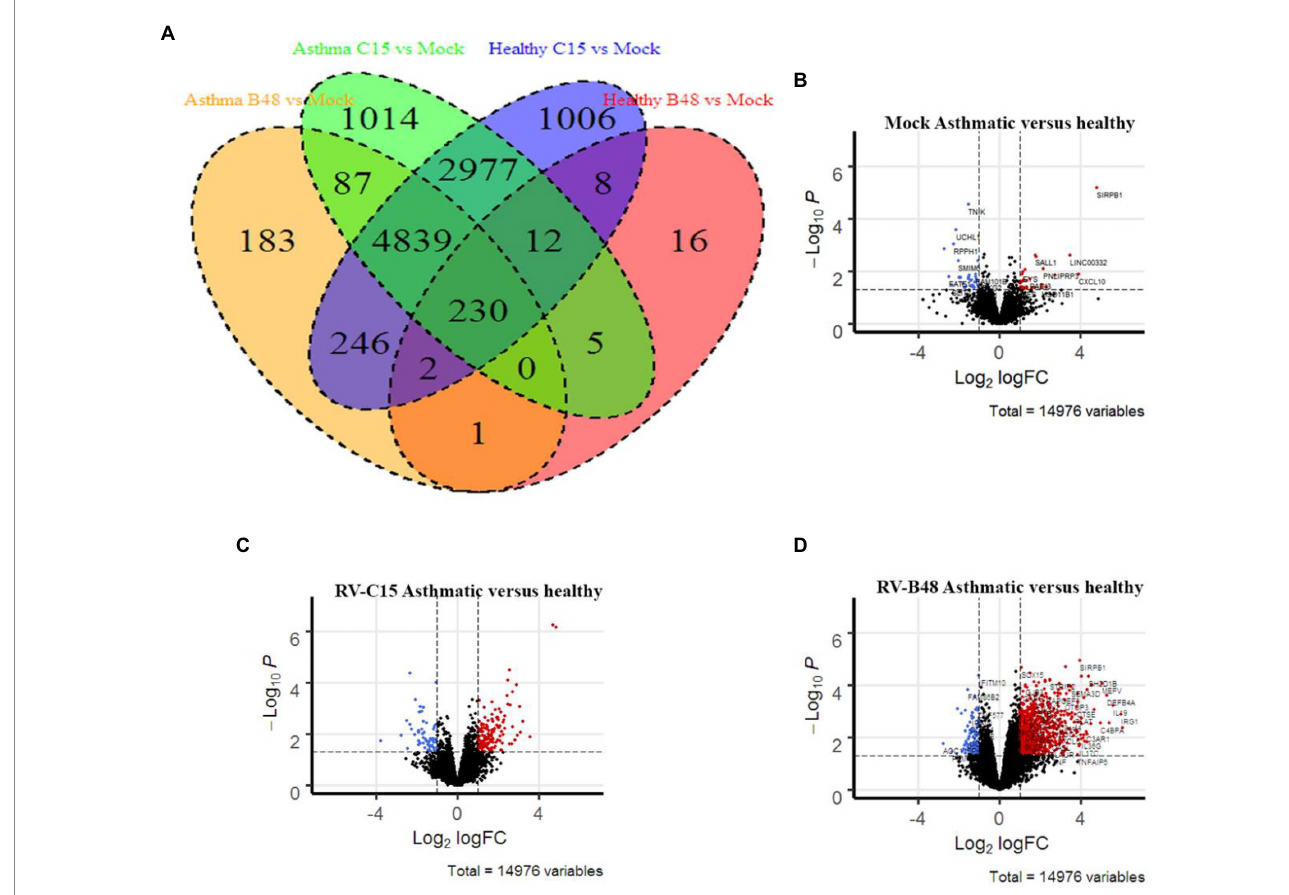
FIGURE 4 Differential gene expression in infected and mock-infected tissues derived from control versus asthmatic donors. (A) Venn diagram comparing the significant gene induction, relative to mock, in RV-B48 and RV-C15-infected tissues from control versus asthmatic donors. (B–D) Volcano plots summarizing the differential gene expression between control and asthmatic donors in (B) mock-infected, (C) RV-B48-infected, and (D) RV-C15-infected tissues. Red and blue dots correspond, respectively, to significantly upregulated and downregulated genes ( p -value < 0.05). Dotted vertical line indicates fold differences of 2, dotted horizontal lines indicate significance at a nominal p -value of